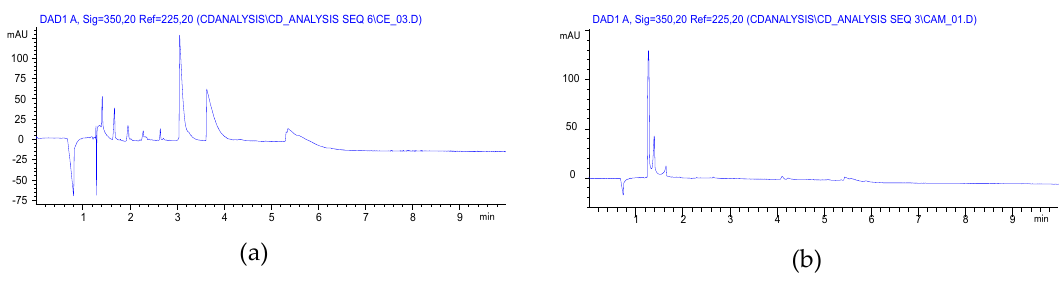
Figure 3. Capillary electropherograms of carboxyethylated β CD ( a ) synthesized from sodium acrylate (compound 3 ′′ , item 7 in Table 1); and ( b ) carboxyethyl residue in carbamoylethyl β CD (compound 5 , item 9 in Table 1).